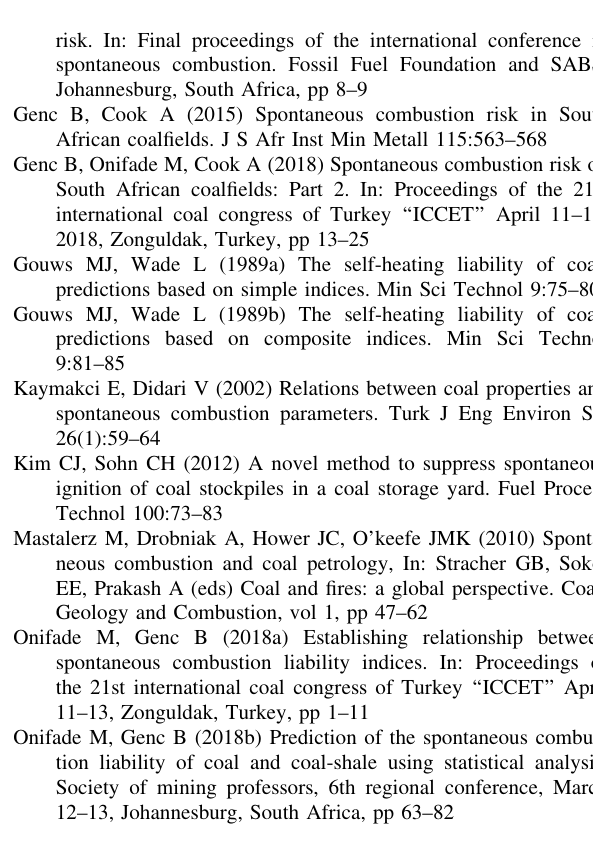
Fig. 10 Influence of total liptinite, sporinite, total reactive macerals, total macerals, and mineral matter on spontaneous combustion liability of